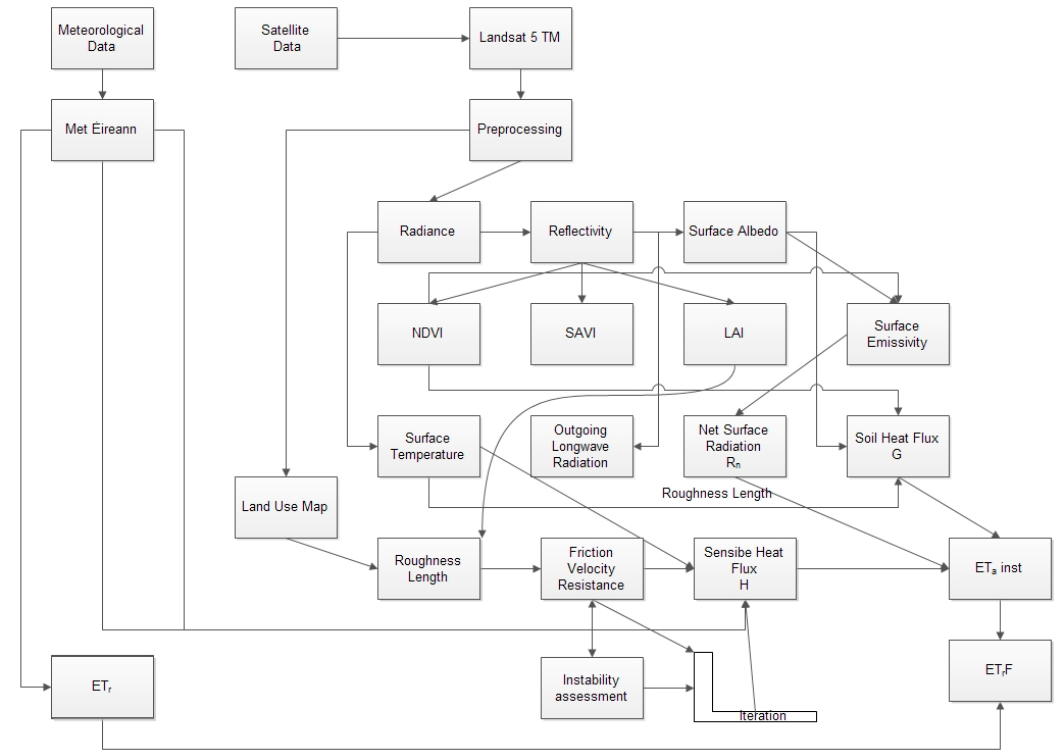
Figure 2. METRIC methodology flowchart.